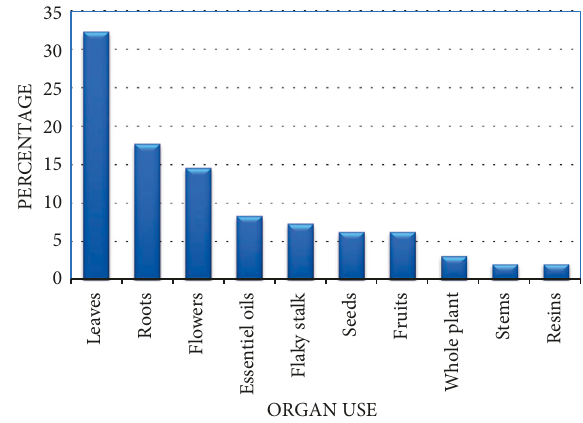
Figure 5: Percentage of organ use of medicinal species in the region studied.